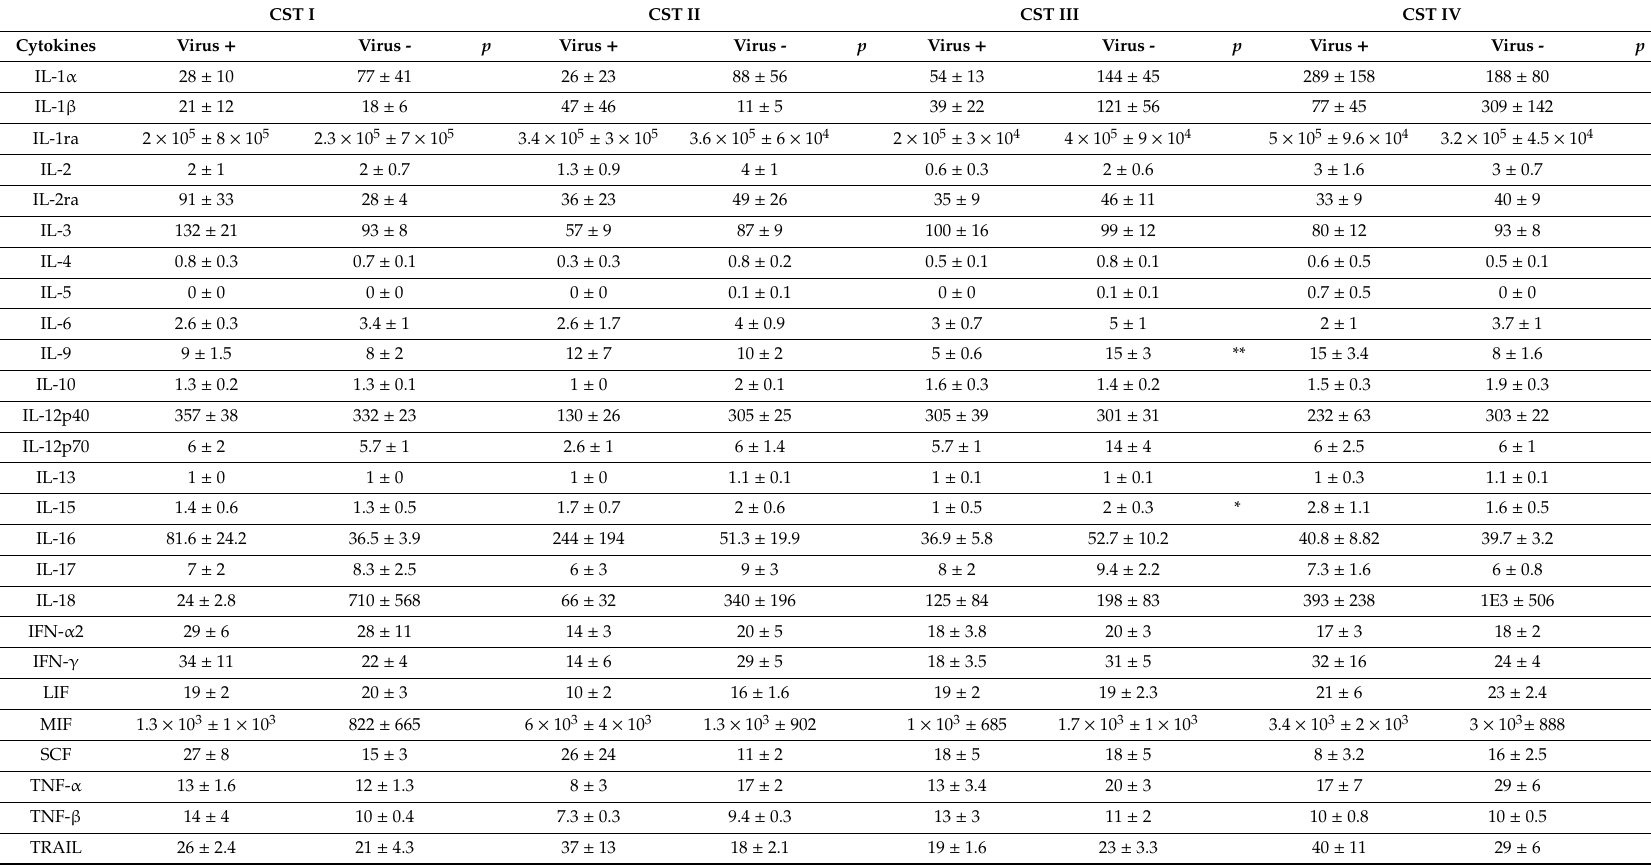
Table 2. The impact of viruses on the immunological di ff erences among CSTs. The figure shows the significantly modulated immune soluble factors between viral DNA negative vs positive samples within each CST ( p value < 0.05). Mixed CST and Bifidobacteria groups are missing as the first group did not show viral DNA while the latter had only one sample positive for viral DNA. Di ff erences were calculated by means of a non-parametric T test for pairwise comparisons among CSTs (GraphPad Prism v. 5). Value are given as mean (pg / mL) ± standard error of the mean (SEM). * p < 0.05, ** p < 0.01, empty cell = p value not significant. Bold = higher value within each